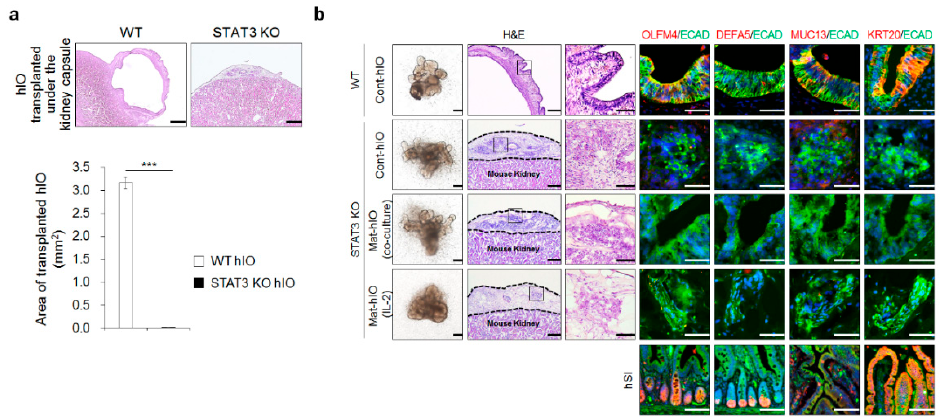
Figure 5. STAT3 KO led to the failure of in vivo growth and maintenance of hIOs. ( a ) H&E staining of hIOs after transplantation into the kidney capsule. Scale bar, 500 µ m. Quantification of the area of transplanted hIOs (WT hIOs: n = 3, STAT3 KO hIOs; n = 6). Data are presented as the mean value of replicates ± SEM. *** p < 0.001 according to Student’s t -test. ( b ) H&E staining of transplanted STAT3 KO hIOs under the kidney capsule. The dotted line indicates where the transplanted hIOs is located. Scale bar, 200 µ m. (High magnification, Scale bar, 50 µ m). Immunofluorescence staining of the intestinal maturation markers in control, co-cultured, and IL-2-treated STAT3 KO hIOs and WT hIOs after maturation under the kidney capsule in vivo. Adult hSI tissues were used as the controls. Scale bar, 50 µ m.